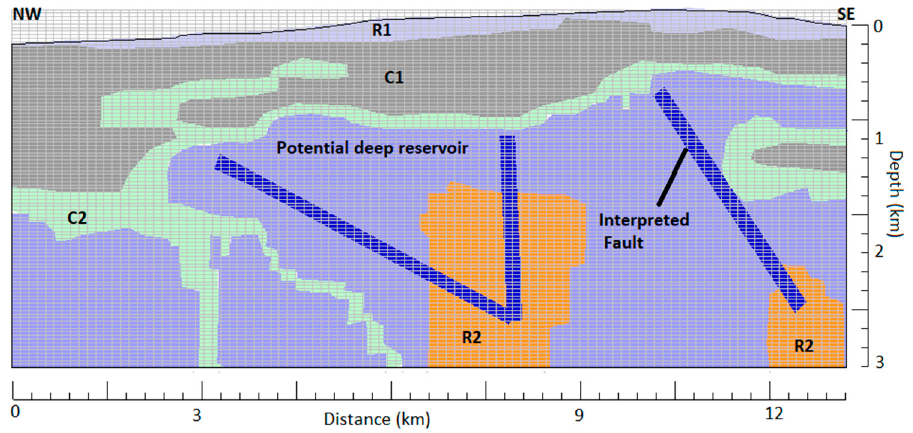
Figure 5. 2D conceptual model interpreted along 2D MT profile in Figure 1.